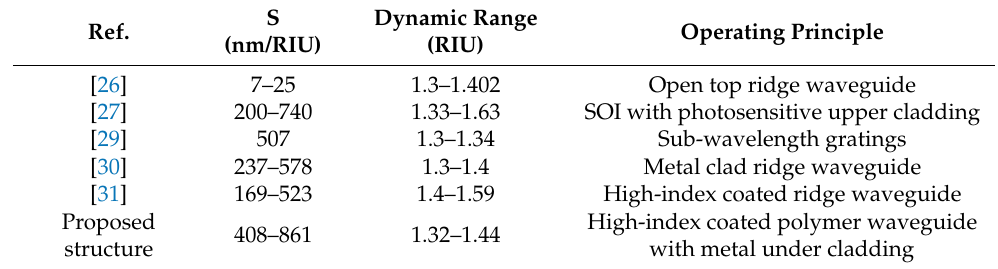
Table 1. Comparison of the proposed sensor with previously reported Bragg grating-based sensors.